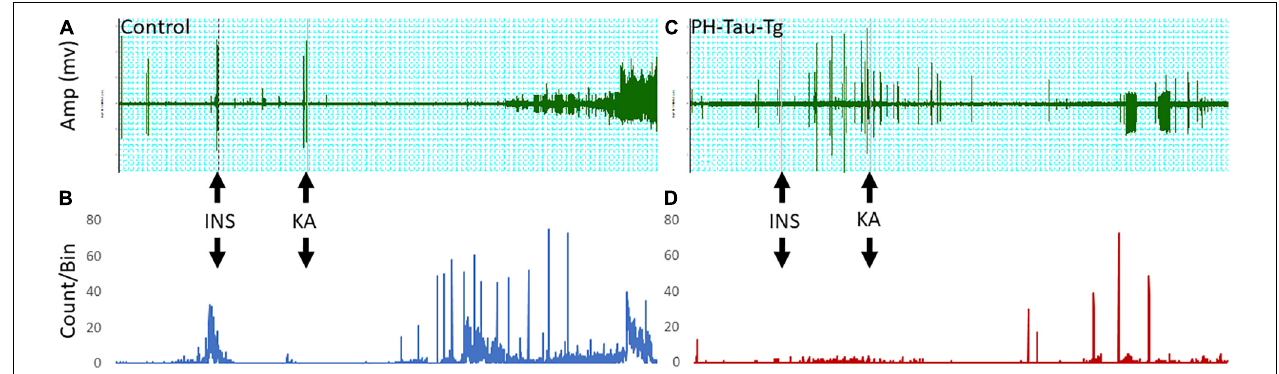
FIGURE 1 | Representative intracerebral recording from the prefrontal cortex of a control mouse (A) and PH-Tau-Tg mouse (C) . Recordings were performed for 15 min (baseline) followed by an i.p. injection of insulin (1IU) at 10 min later and KA (5 mg/kg) at t25. Onset of high frequency discharge and ictal activity occurred about 20 to 30 min post KA injection. In controls, once seizures occurred there was no recovery and the amplitude of the population spikes almost doubled and remained so for the duration of the recordings. In PH-Tau-Tg mice the latency was the same as controls, however, the amplitude of the population spikes was significantly lower and ictal activity was intermittent and interrupted with interictal events (C) . Spike histograms analysis of firing rates with a detection threshold of 0.1 mv and a Bin size of 1 s showed a significant increase after KA injection in controls (B) and drastic decrease post KA-injection in PH-Tau-Tg mice (C) ( n = 3 of each group) Shown here are representative intracerebral recordings from individual mice.